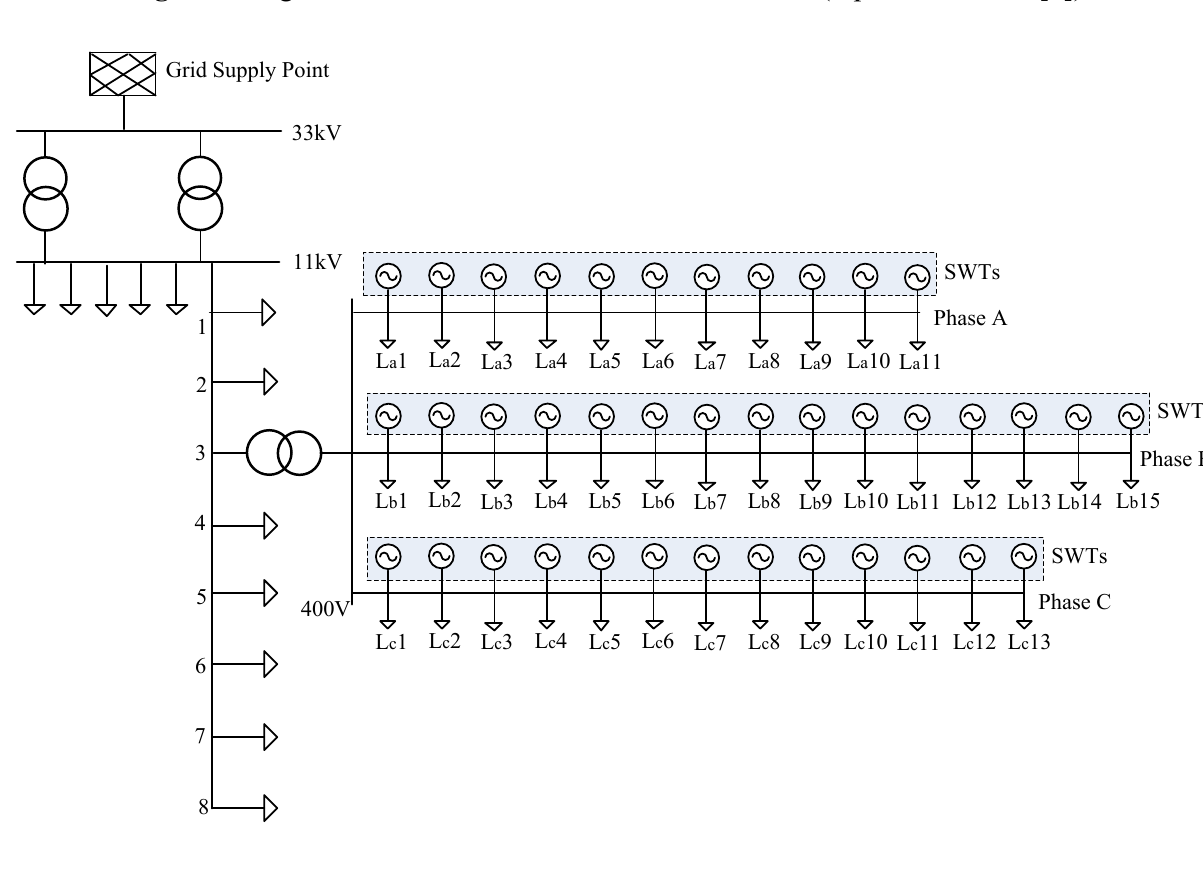
Figure 3. A generic UK distribution network with SWTs (reproduced from